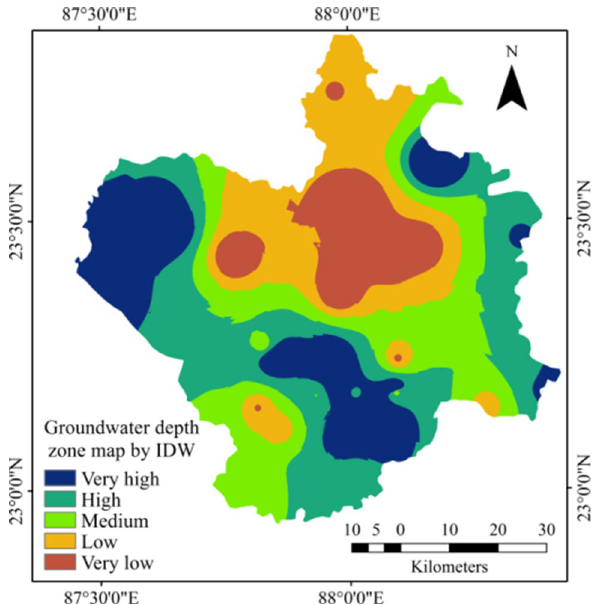
Fig. 11 Ground water depth zone